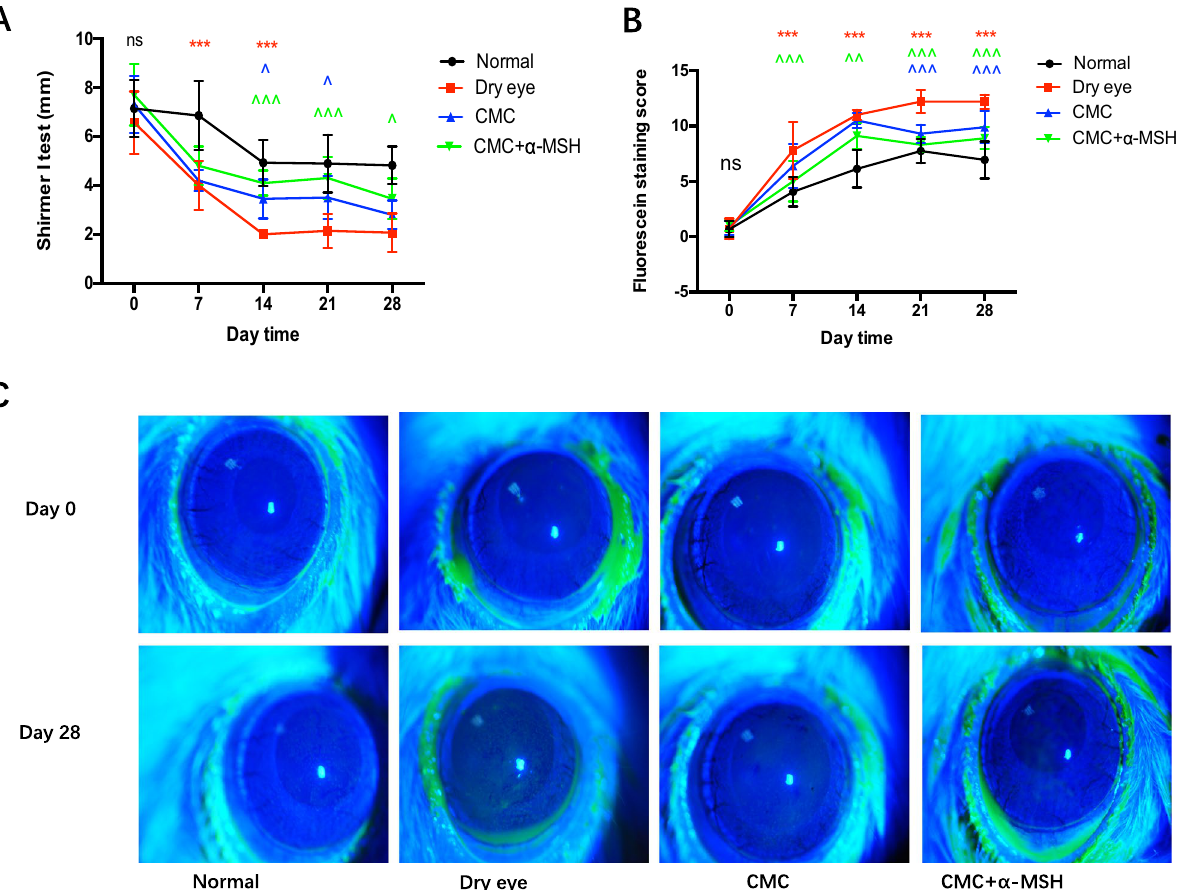
Figure 1. Combined CMC + α-MSH treatment ameliorated ocular surface dysfunction in rats with scopolamine-induced dry eye. Rats were divided into normal (black line), dry eye (red line), CMC (blue line), and α-MSH (green line) groups. Schirmer’s test ( A ) and corneal fluorescein staining ( B ) were performed weekly. Representative images of corneal fluorescein staining before and after the experiment are shown ( C ). Data are shown as mean ± SEM, n = 10 per group. * p < 0.05; ** p < 0.01; *** p <